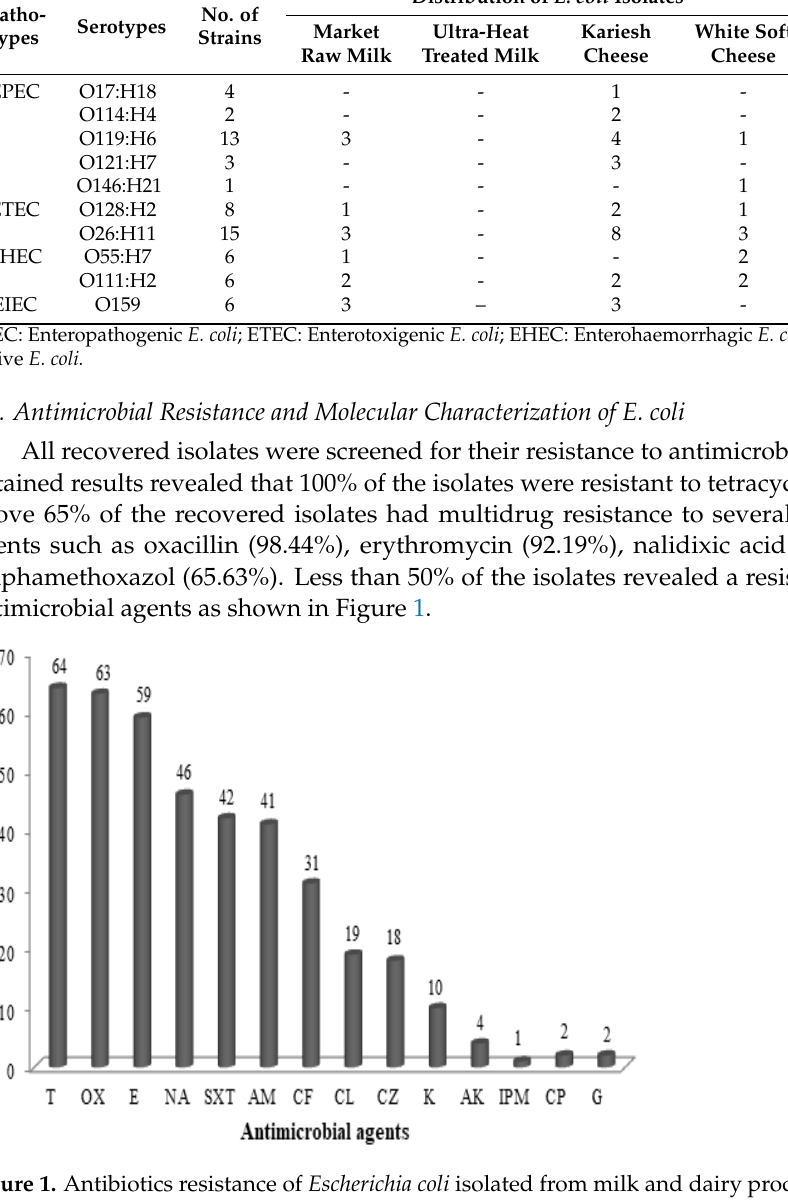
Figure 1. Antibiotics resistance of Escherichia coli isolated from milk and dairy products. T: